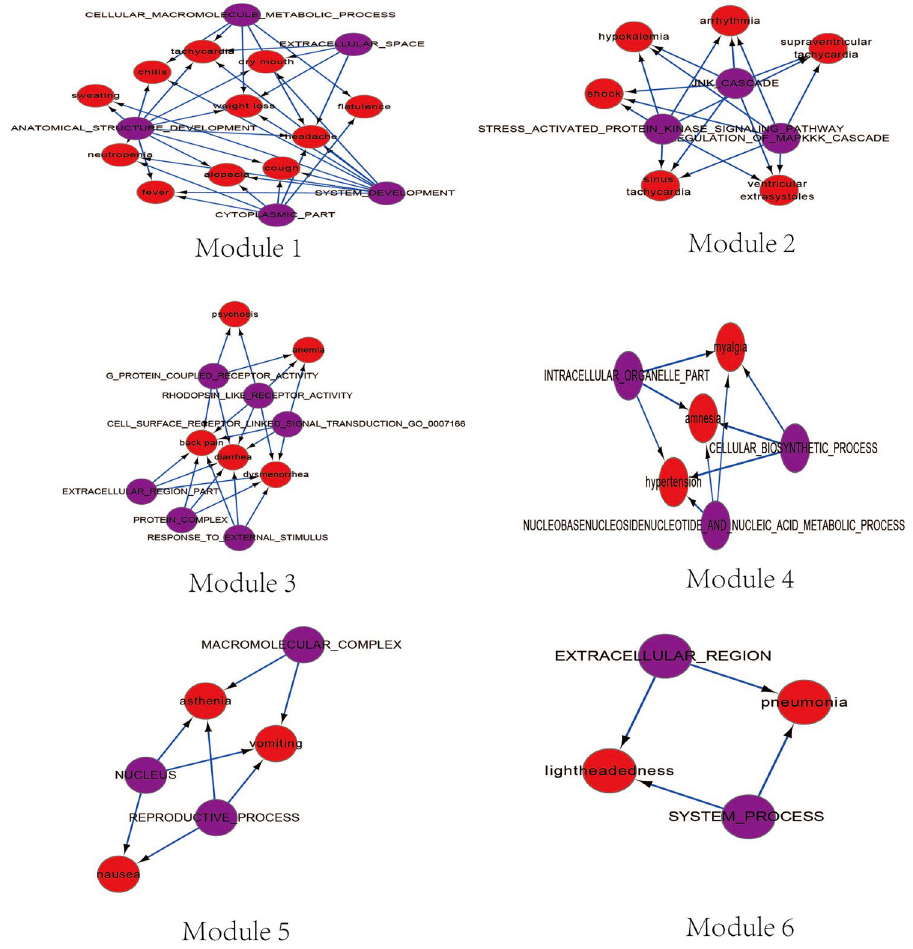
Figure 4. Side effects-gene sets modules. Purple points represent gene sets and red points represent side effects. The side effects within each SE-gene set module often occur simultaneously because they share the same gene sets, e.i. with similar SE occurrence